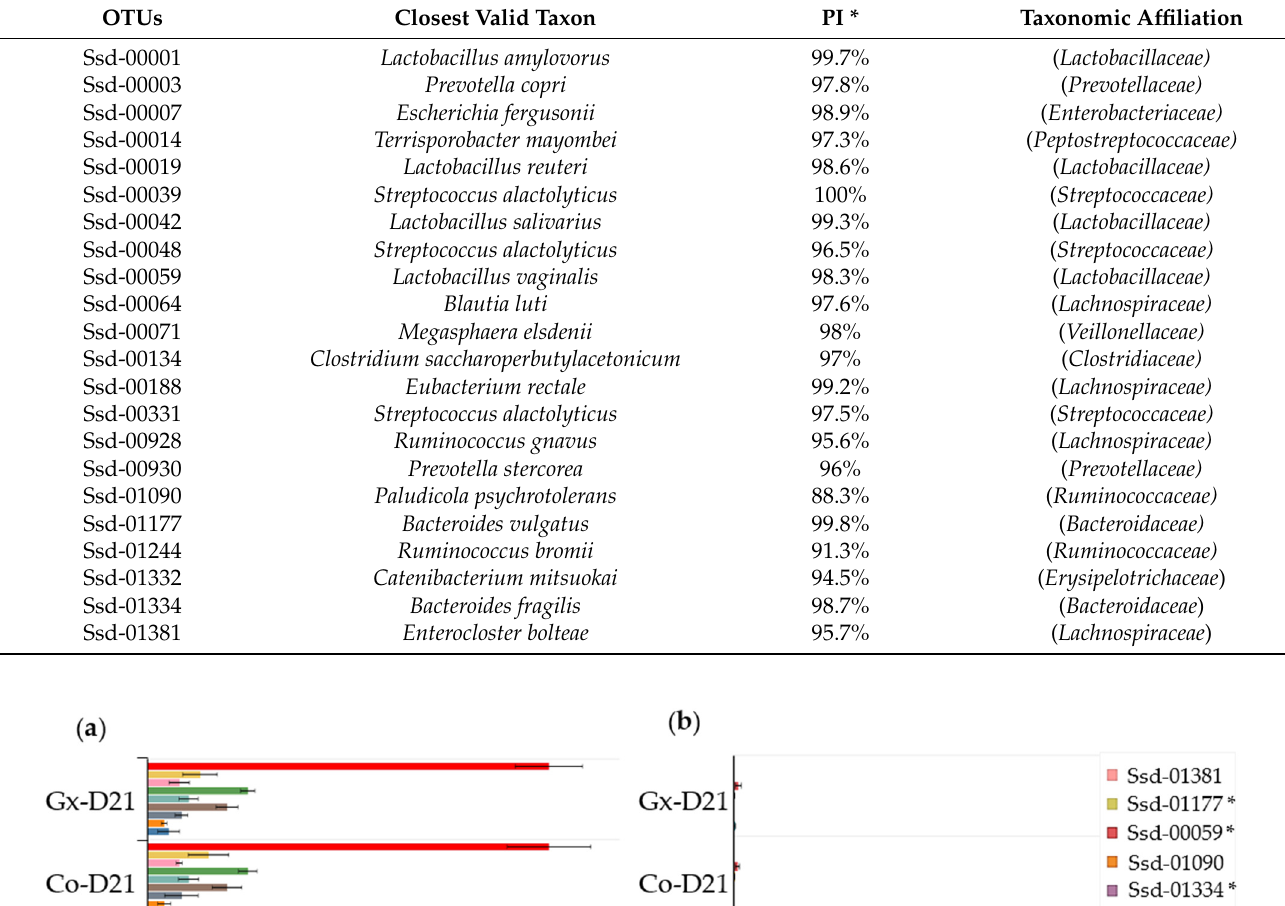
Table 4. Closest valid relatives for the main bacterial OTUs that showed a difference in abundance between supplemented (Gx) and non-supplemented (Co) groups ( p < 0.05). * PI: Percent Identity.